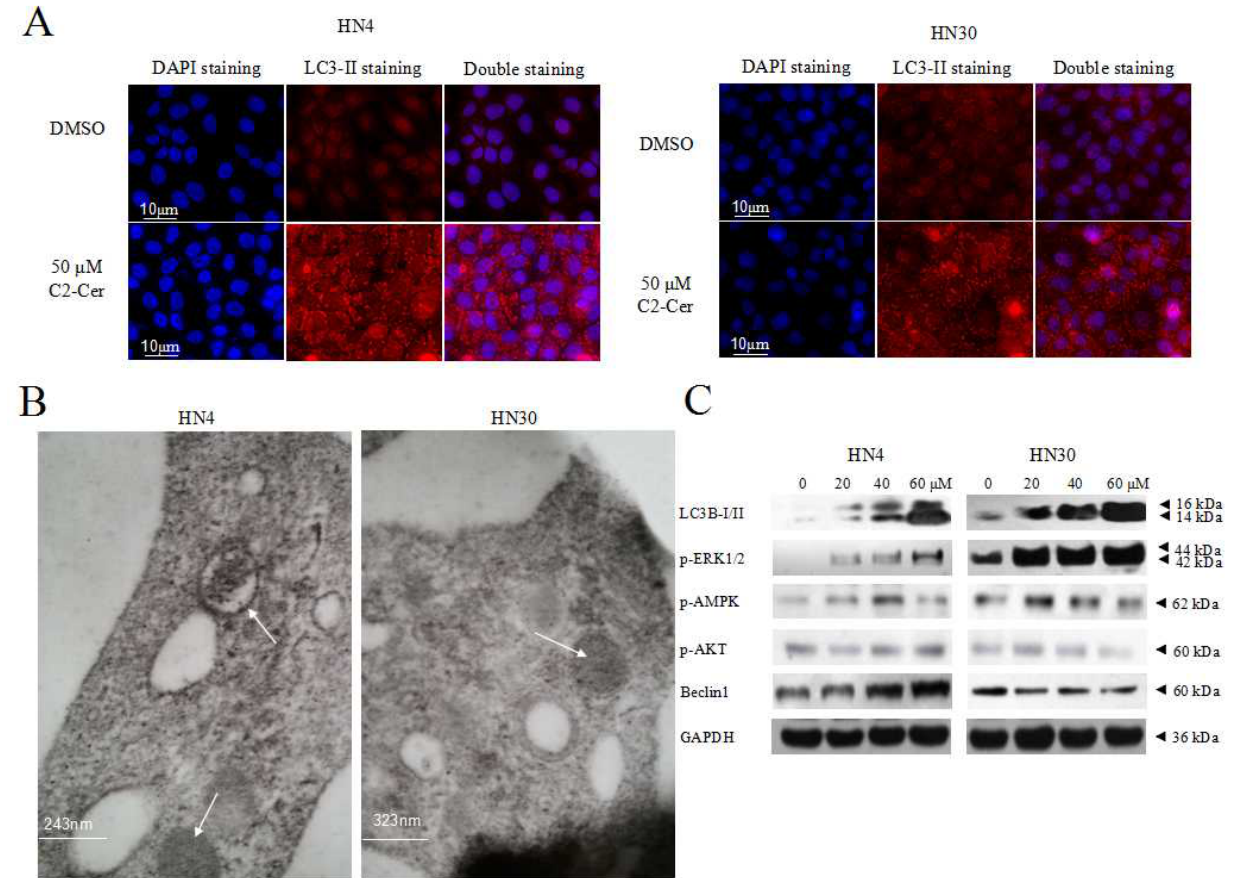
phospho-AMP-activated protein kinase (p-AMPK), p-Akt, Beclin 1) were analyzed. Levels of LC3B-II and p-ERK1/2 were elevated after treatment of cells with C2-Cer. Other protein levels remained unaffected by C2-Cer